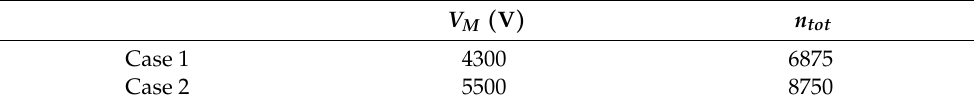
Table 4. The required charging voltage and the total number of battery cells of two